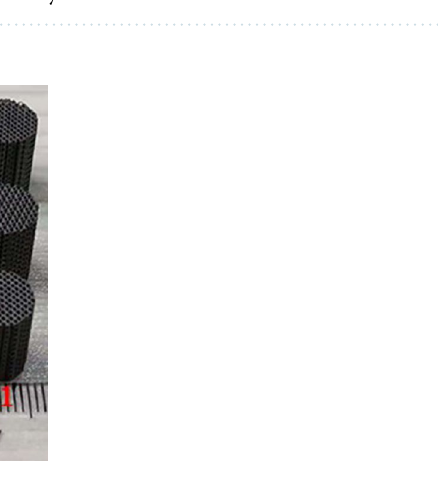
Table 1. Properties of Ti6Al4V materials in finite element analysis.